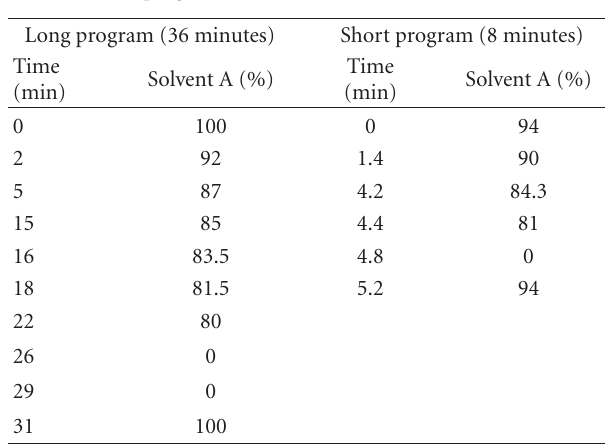
Table 3: Solvent gradients in the “long” and “short” HPLC analyses of hydroxycinnamates in extracts of chicory leaf tissue. Solvent A consisted of water for the “long” program and water/1% acetic acid for the “short” program.